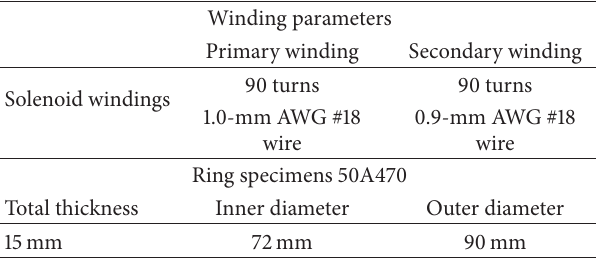
Table 2: Traditional toroidal